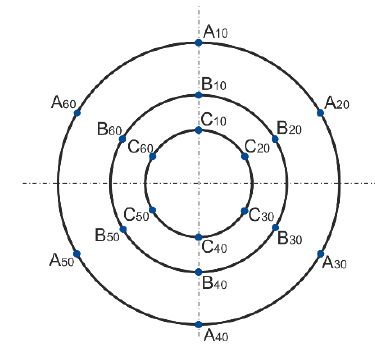
Fig. 13. Placement of K-Thermocouples on a double annulus